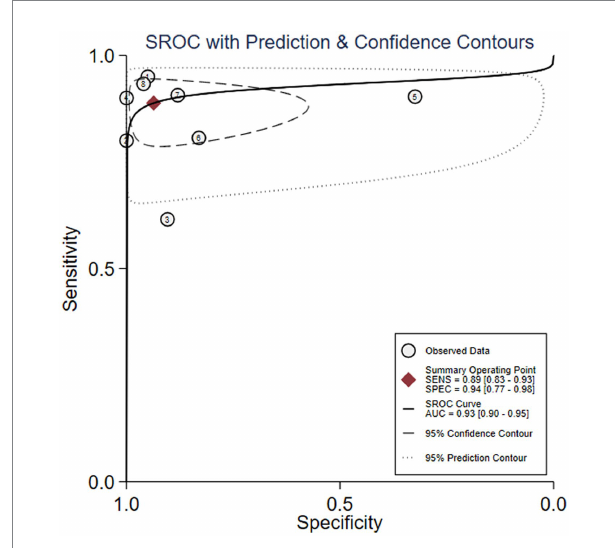
FIGURE 5 Soluble Urokinase-type plasminogen activator receptor (suPAR) symmetrical summary receiver operator characteristic (SROC) curve for all eight studies.